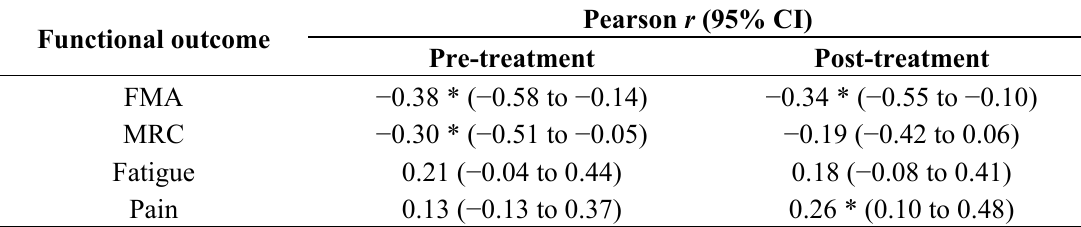
Table 3. Correlations between 8-OHdG levels and functional outcomes before and after rehabilitation intervention ( N = 61). Abbreviations: 8-OHdG, 8-hydroxy-2'-deoxyguanosine; CI, confidence interval; FMA, Fugl-Meyer Assessment; and MRC, Medical Research Council scale. * p < 0.05.